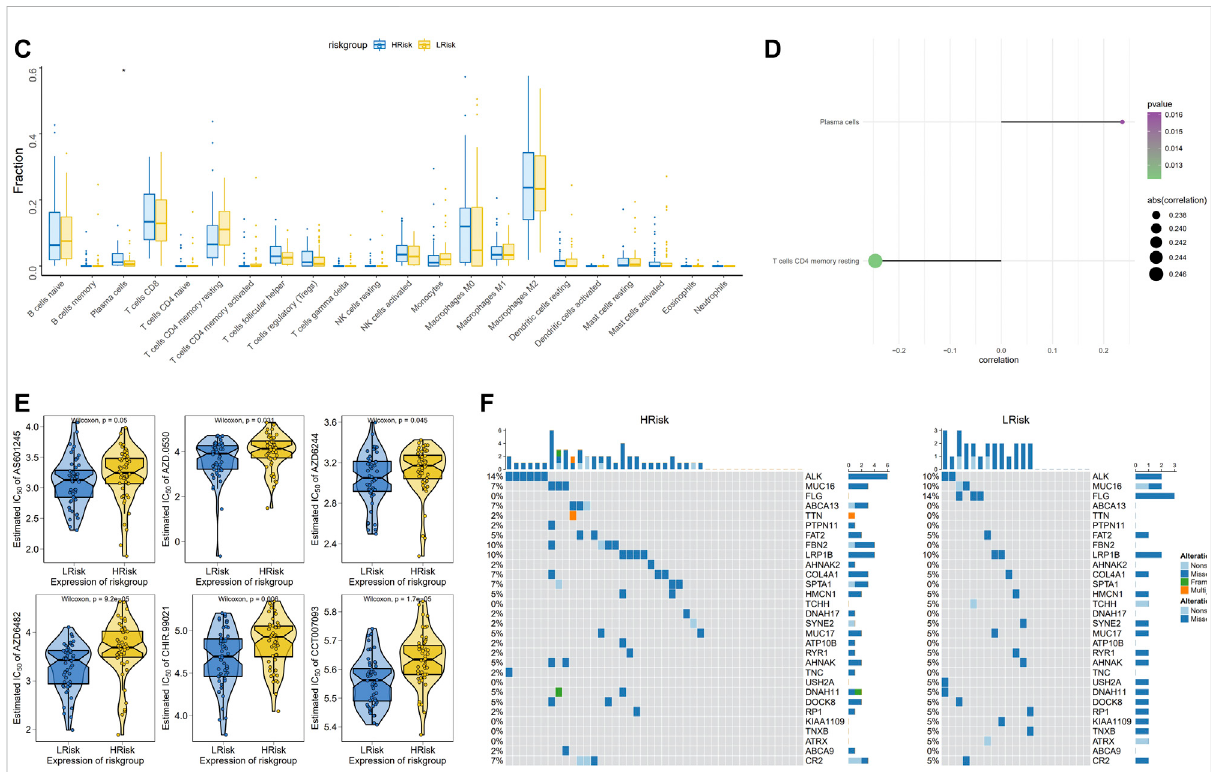
FIGURE 3 Multi-omicsanalysisoftheclinicalpredictivevalueofthemodel. (A) Stackedbarchartofthedistributionof22immunecellsineachNBLsample of the TARGET cohort; (B) Pearson correlation between immune cells, red for positive correlation, purple for negative correlation; (C) Differences in immune cell counts between the high-risk and low-risk groups; (D) The correlation between the risk score and the immune cells, the circle size indicates the strength of the correlation, and the color indicates the p -value; (E) The difference on the therapeutic sensitivities of six chemotherapy drugs; (F) Mutation pro fi les of patients in the high and low risk groups, yellow for high risk group and blue for low risk